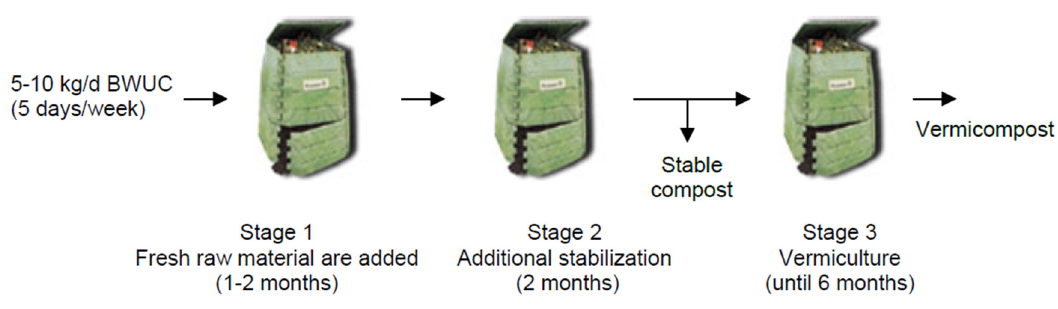
Figure 3. Composting process diagram at the Philology Faculty (Composter volume: 340 L). Table 3. Operational characteristics of the second composting batch in the Philology Faculty.